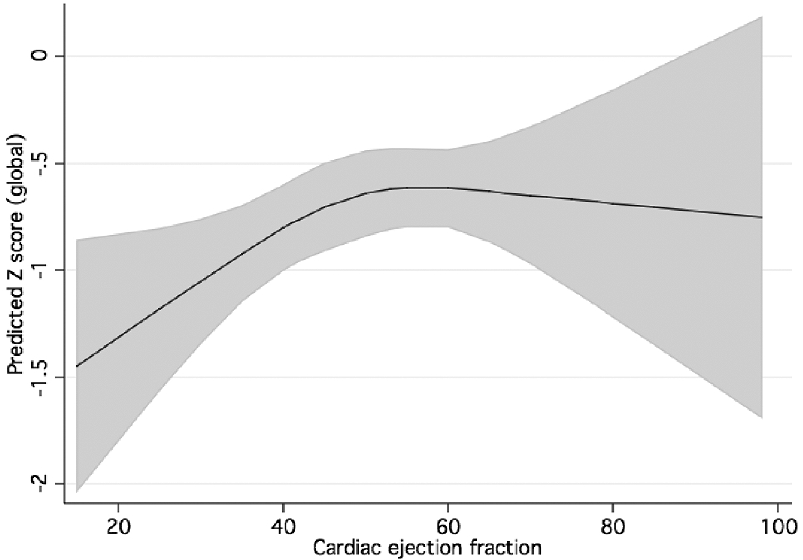
Fig. 2. Cubic spline demonstrating association between global cognition Z-score and cardiac EF. The predicted association with 95% confidence bands are